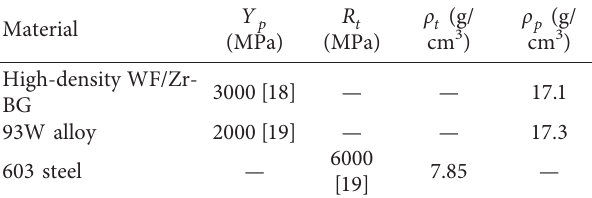
Table 3: Material information of projectile and